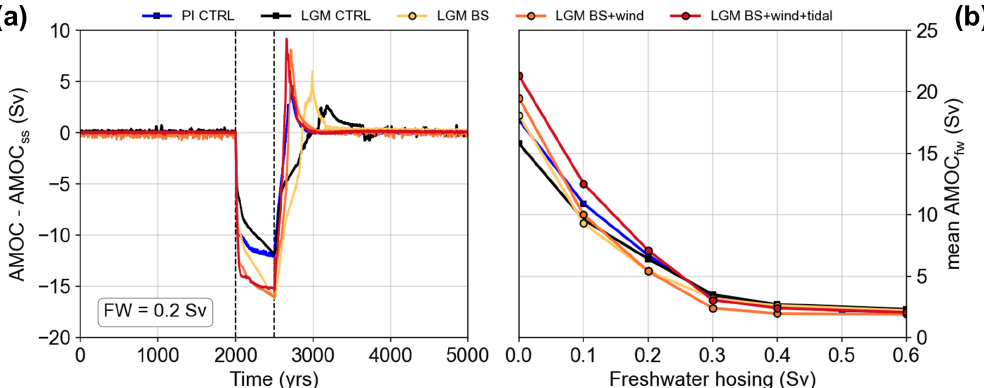
Figure 4. (a) AMOC responses to freshwater perturbation of 0.2Sv for 500 years in the North Atlantic for the different simulations listed in Table 1. Vertical dashed lines mark the start and end of hosing. To compare the AMOC anomalies, the steady-state AMOC strength (AMOC ss ) has been subtracted from the AMOC signal. (b) The 500-year average of AMOC strength during the freshwater perturbation (AMOC fw ) versus the amount of freshwater hosing.